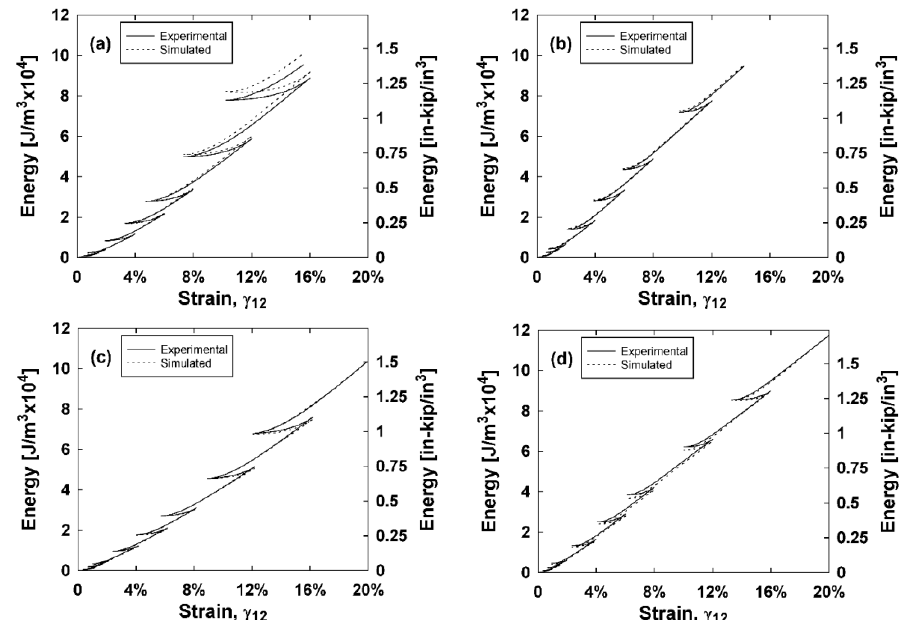
Figure 10. Experimental and simulated ( a ) E-glass; ( b ) E-glass hybrid; ( c ) S-glass; and ( d ) S-glass hybrid energy dissipated versus shear strain curves.